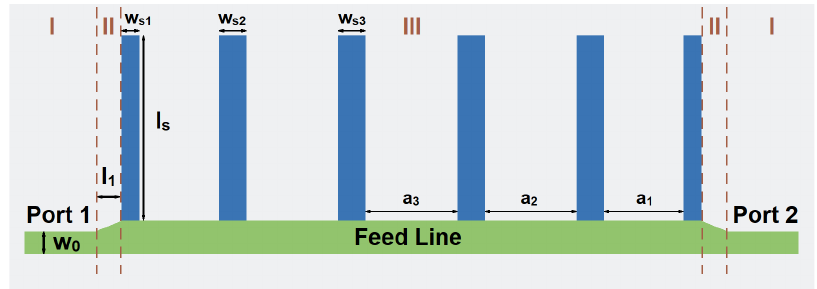
Figure 6. The topology of the high-order SSPP structure.